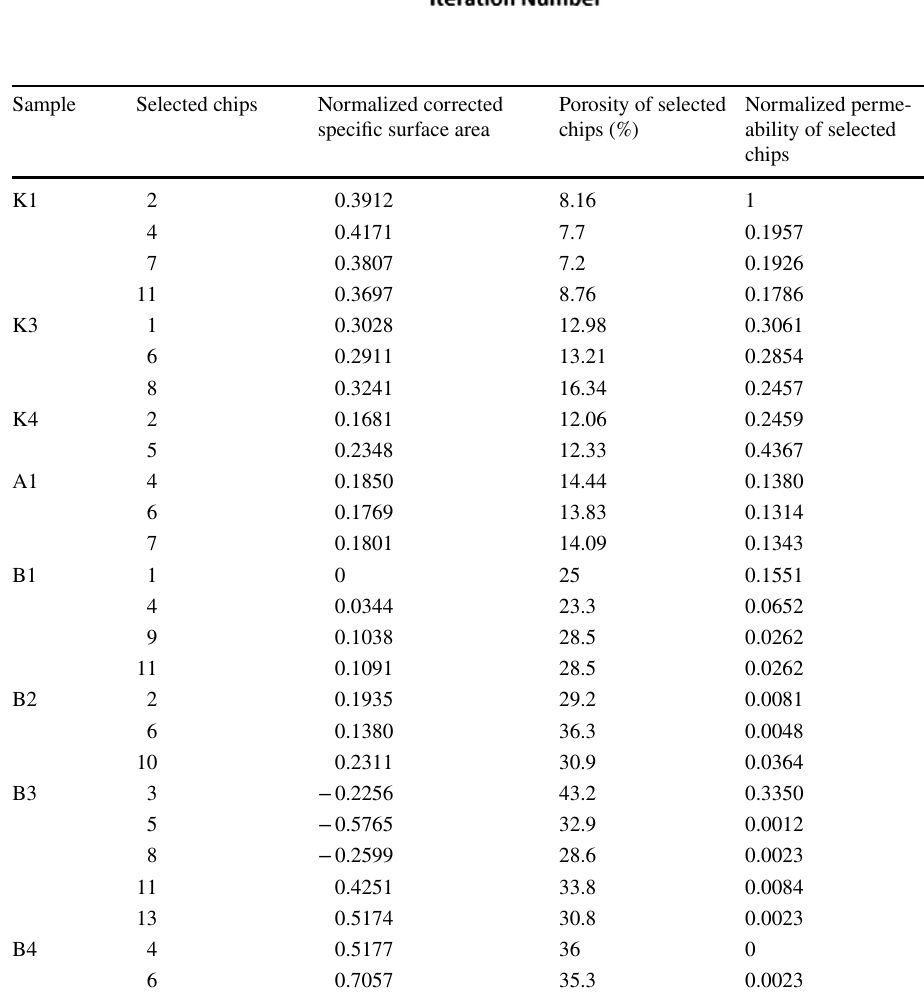
Sample Selected chips Normalized corrected